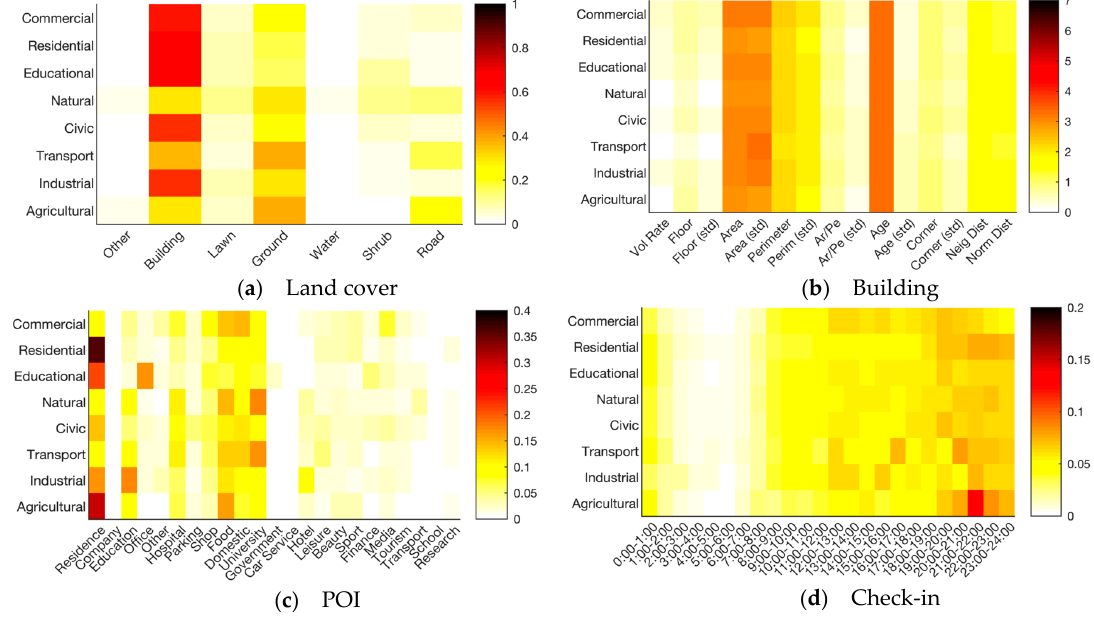
Figure 7. Feature analysis for different land use types.